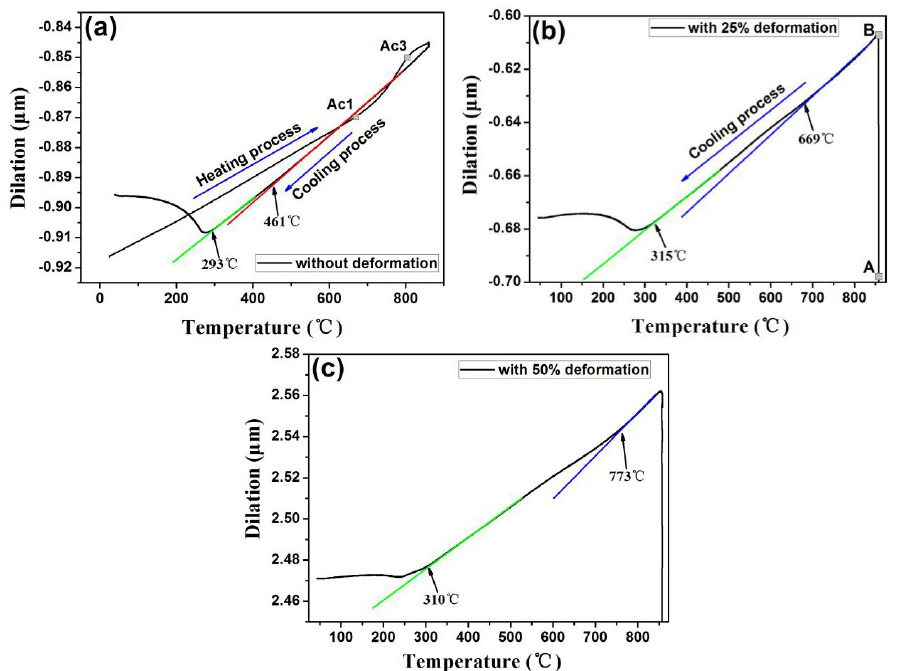
Figure 5. The dilation curves of different specimens: (a) without deformation; (b) 25% strain; (c) 50%